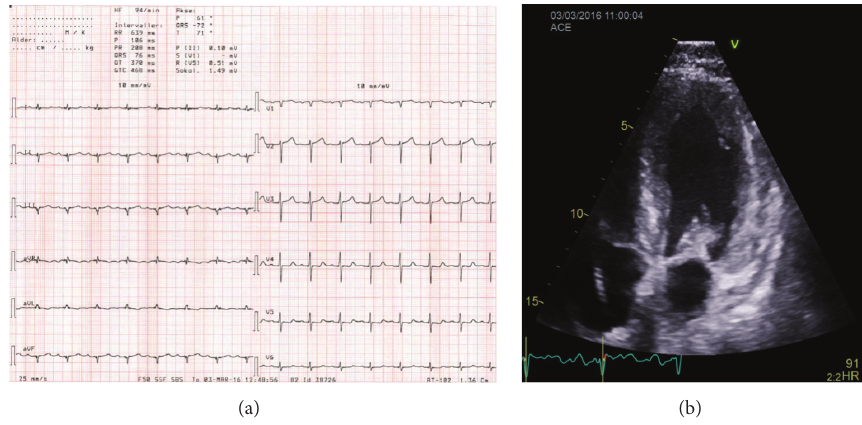
Figure 1: (a) Electrocardiogram. (b) Echocardiographic apical four-chamber view.